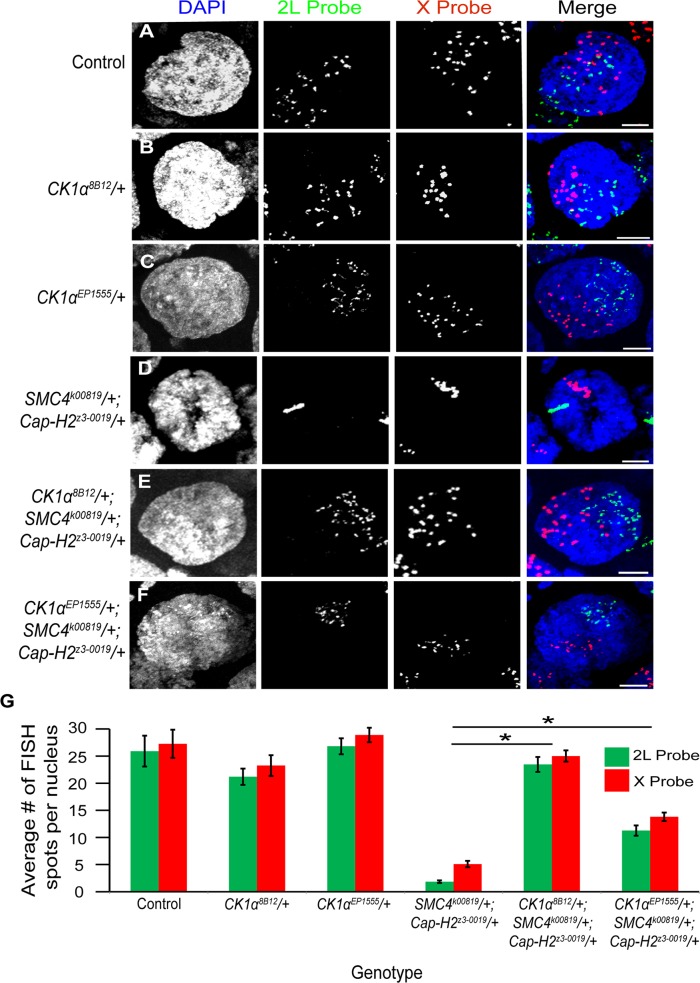
CK1α mutations suppress condensin II loss of function unpairing phenotype in polyploid nurse cells.(A-F) Micrographs of stage 10 nurse cell nuclei from control (triple balancer) (A), CK1α8B12/+ heterozygote mutant (B), CK1αEP1555/+ heterozygote mutant (C), condensin II double heterozygous mutant SMC4k00819/+; Cap-H2z3–0019/+ (D), CK1α8B12/+ heterozygote in condensin II double heterozygous background (CK1α8B12/+; SMC4
k00819/+; Cap-H2z3–0019/+) (E), and CK1αEP1555/+ heterozygote in condensin II double heterozygous background (CK1αEP1555/+; SMC4k00819/+; Cap-H2z3–0019/+) (F) were stained with FISH probes specific to Chromosome 2L (green) and Chromosome X (red) and counterstained with DAPI (DNA, blue). Condensin II loss of function mutants (SMC4k00819/+; Cap-H2z3–0019/+) (D) show a defect in chromosome unpairing (fewer FISH spots), which is strongly suppressed when a CK1α
8B12/+ heterozygous mutation (E) is introduced into this background (dispersal of FISH spots). CK1α
EP1555/+ shows similar but weaker suppression when introduced into condensin II double heterozygous background (F). (G) Histogram showing the average number of FISH spots for each probe in stage 10 nurse cells (n = 15–26 nurse cells per genotype). Error bars indicate SEM. *p-value < 2.2x10−10 (calculated by using students’ t-test in MS Excel). (A-F) Maximum projection image of multiple z-slices. Scale, 10μm.